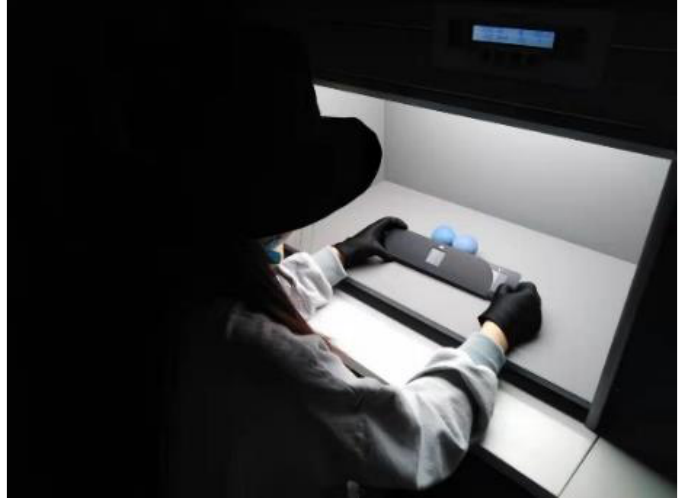
Figure 5. The visual color-difference assessment.